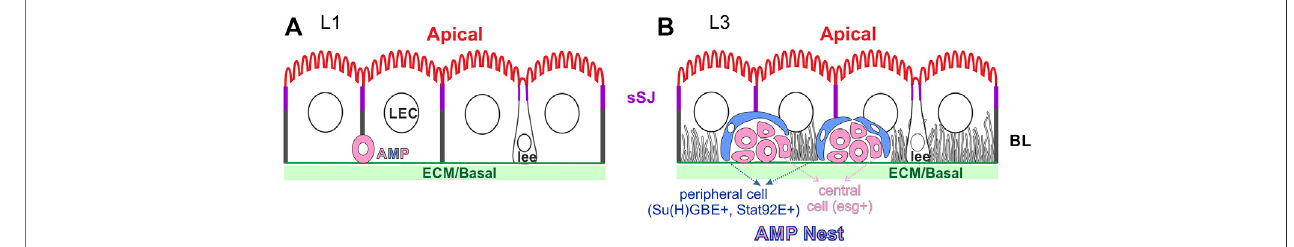
FIGURE3| Theorganisationofthelarvalmidgut.Thelarvalenterocytes(LEC)haveasimilarpolaritytotheadultECs,withanapicalbrushborder,sSJsandabasal labyrinth (BL) (possibly only at later stages). The larval ee cells (lee) have inserted into the larval midgut epithelium and are bottle-shaped, like adult ee cells. (A) The esg + AMPs keep dividing during the fi rst larval instar and the daughter cells migrate and distribute along the basal surface of the epithelium. (B) 1-3 10xSTAT92E-GFP + peripheralcells(blue)ensheaththediploidcentral, esg +cells(pink)toformtheAMPnestsinthelatethirdinstarlarvalmidgut.SomecellsineachnestbecomePros + at this stage and will contribute to the future tPMG.